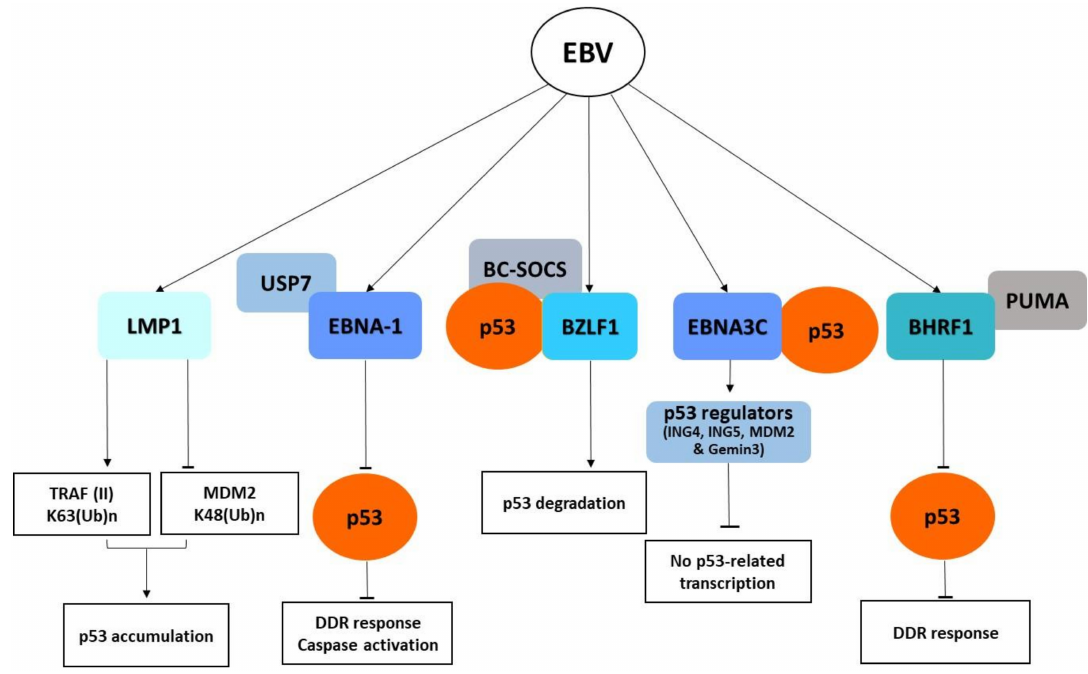
Figure 1. Schematic diagram of Epstein–Barr virus (EBV) oncoproteins affecting p53 signaling pathways. DDR, DNA damage